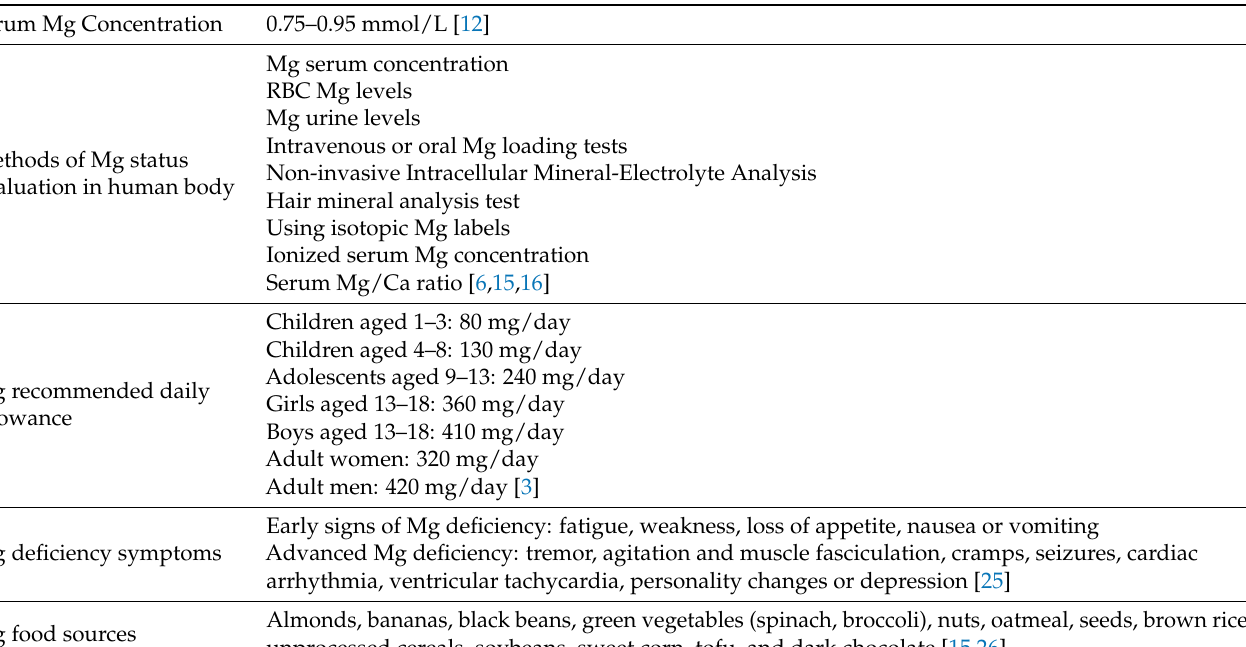
Table 1. Key elements in magnesium